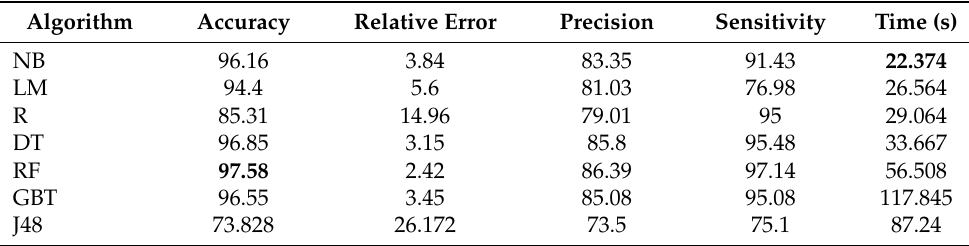
Table 9. Comparison between different algorithms applied on preprocessed diabetes data.